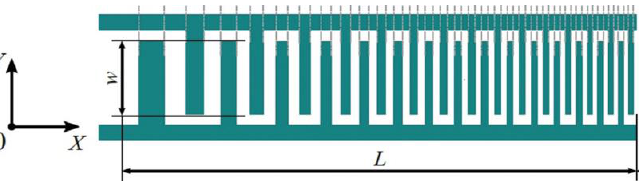
Figure 15. Schematic representation of the dispersive delay line electrode configuration [153].